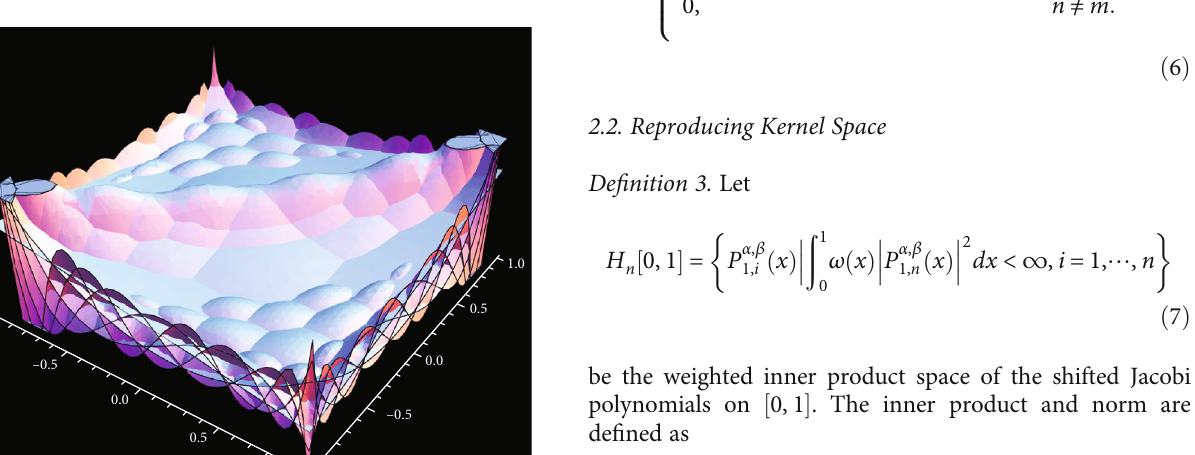
y Þ with n = 3, α = β = 0 : x ð